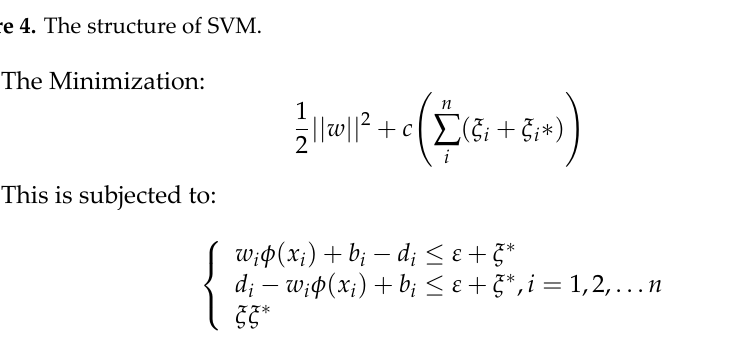
Figure 4. The structure of SVM.